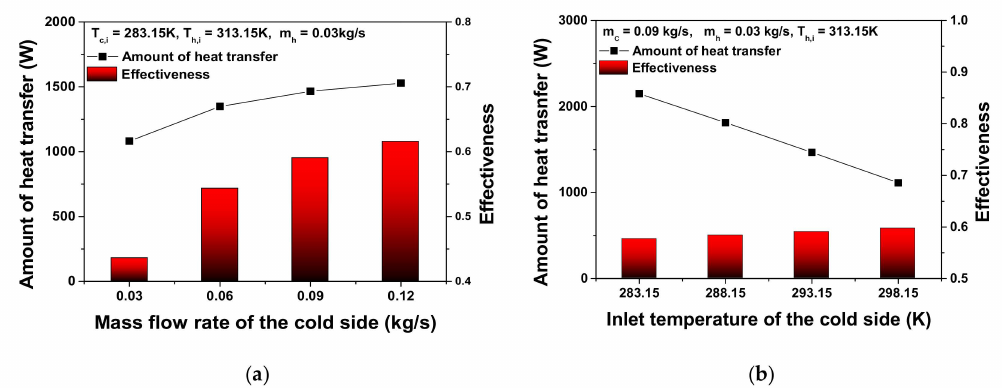
Figure 4. Amount of heat transfer and effectiveness: ( a ) according to the mass flow rate of the cold side, ( b ) according to inlet temperature of the cold